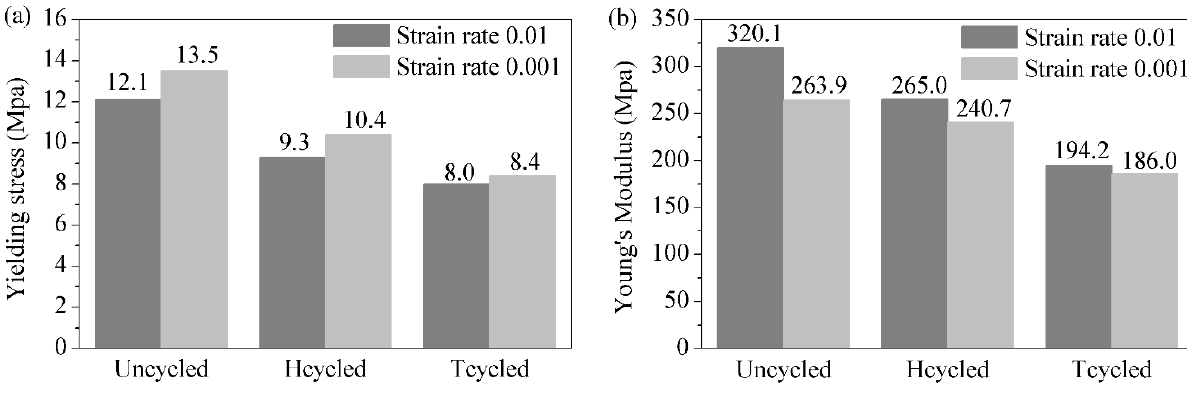
Figure 3. The ( a ) yielding stress and ( b ) Young’s modulus of N117 dog-bone tensile test under different strain rates (0.01 s −1 and 0.001 s −1 ) and different cycling treatments.